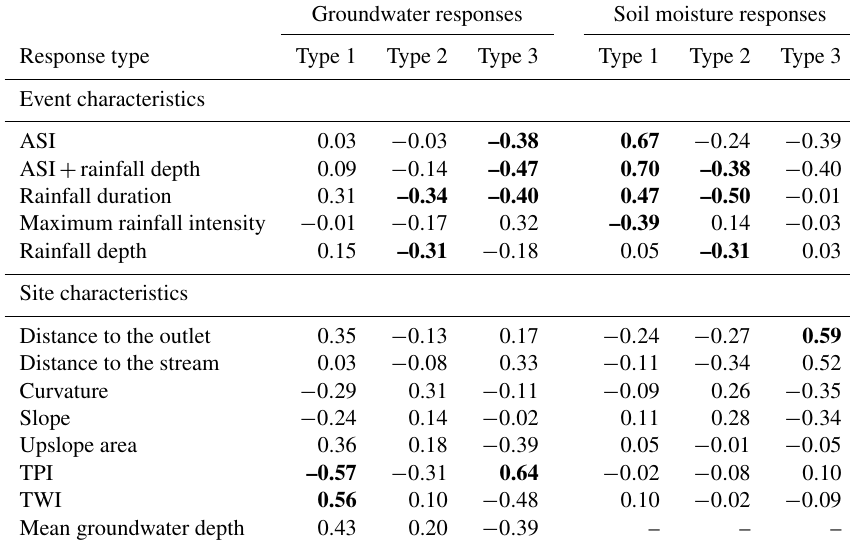
Table 3. Pearson correlation coefficient of site and event characteristics with the frequency of different event response types of groundwater and soil moisture in relation to the streamflow. ASI is the antecedent soil moisture index. TPI and TWI are topographic position index and topographic wetness index, respectively. The significance of correlations was tested with t -distribution approximation and correlations with p < 0 . 05 are shown in bold.